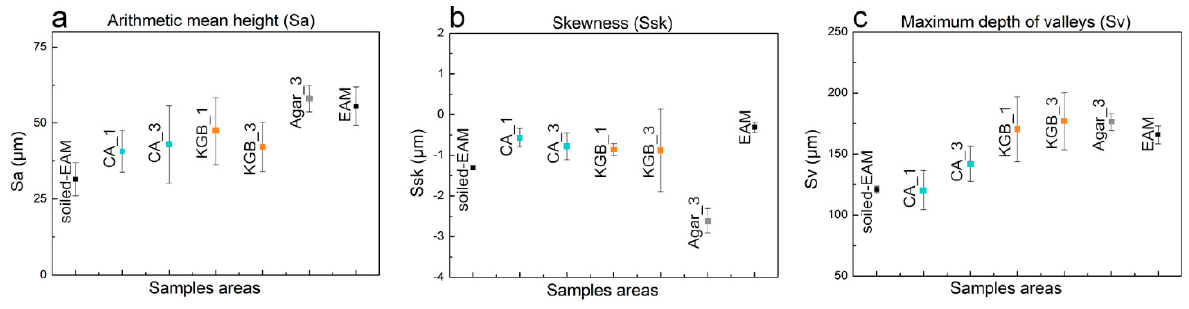
Figure 9. Considered roughness values of Sa ( a ), Ssk ( b ), and Sv ( c ) on the different areas of EAM and soiled − EAM cleaned by different gels and application time CA_1, CA_3, KGB_1, KGB_3, and Agar_3.